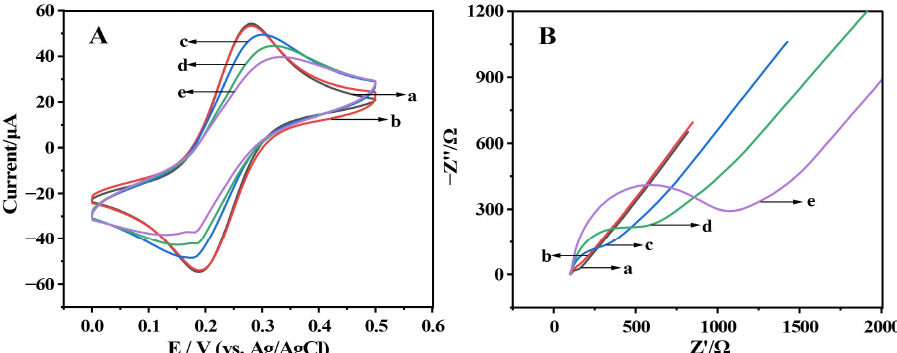
Figure 1. ( A ) Cyclic voltammetry curves of different modified electrodes; ( B ) Nyquist plots of different modified electrodes. (a) bare GCE, (b) Au/GCE, (c) LNA/Au/GCE, (d) Apt/LNA/Au/GCE, (e) SE/Apt/LNA/Au/GCE.